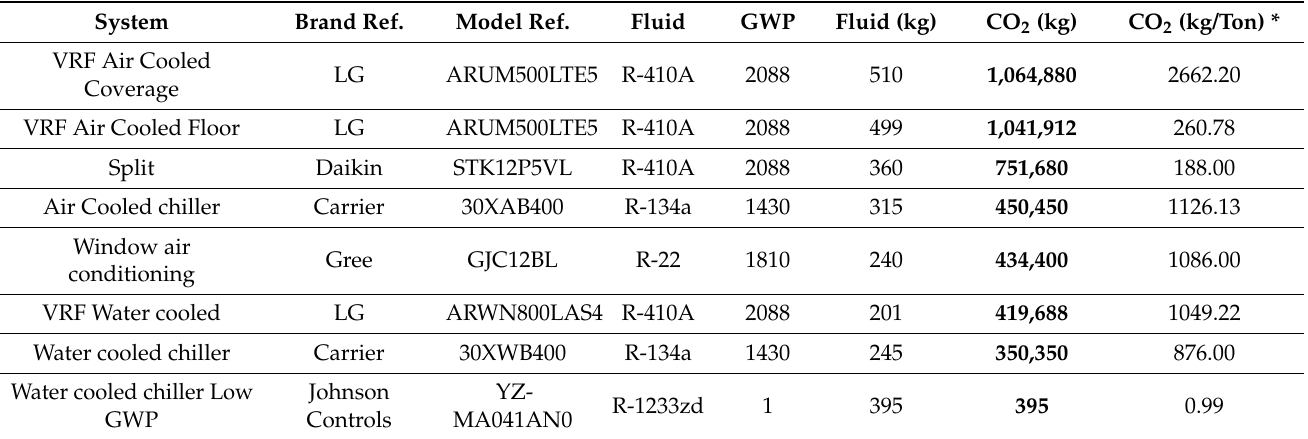
Table 1. Comparison of the amount of CO 2 emissions for each type of system.